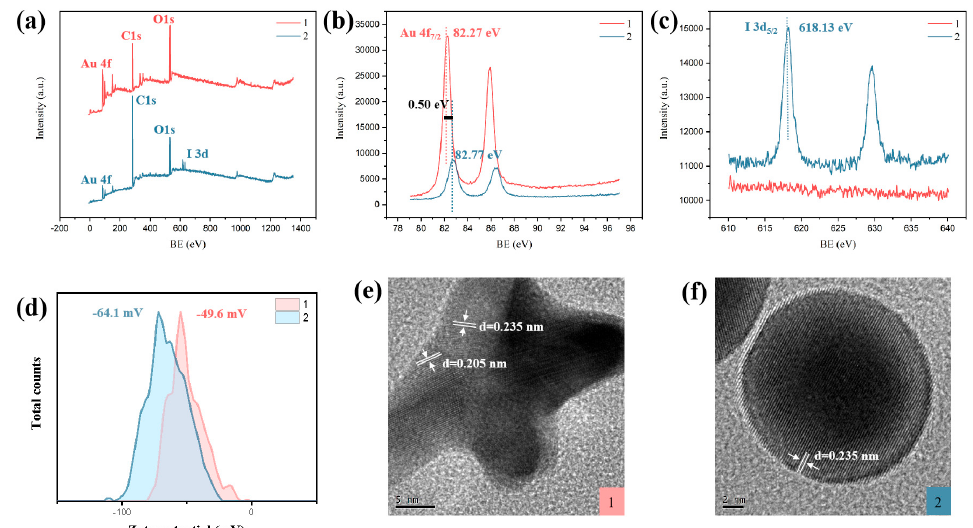
Figure 5. XPS survey spectra of GNSs ( a ), Au 4f ( b ), and I 3d ( c ), Zeta potentials ( d ), and HRTEM images ( e , f ) of GNSs before (1) and after (2) incubation with 2 µM iodide for 90 min.